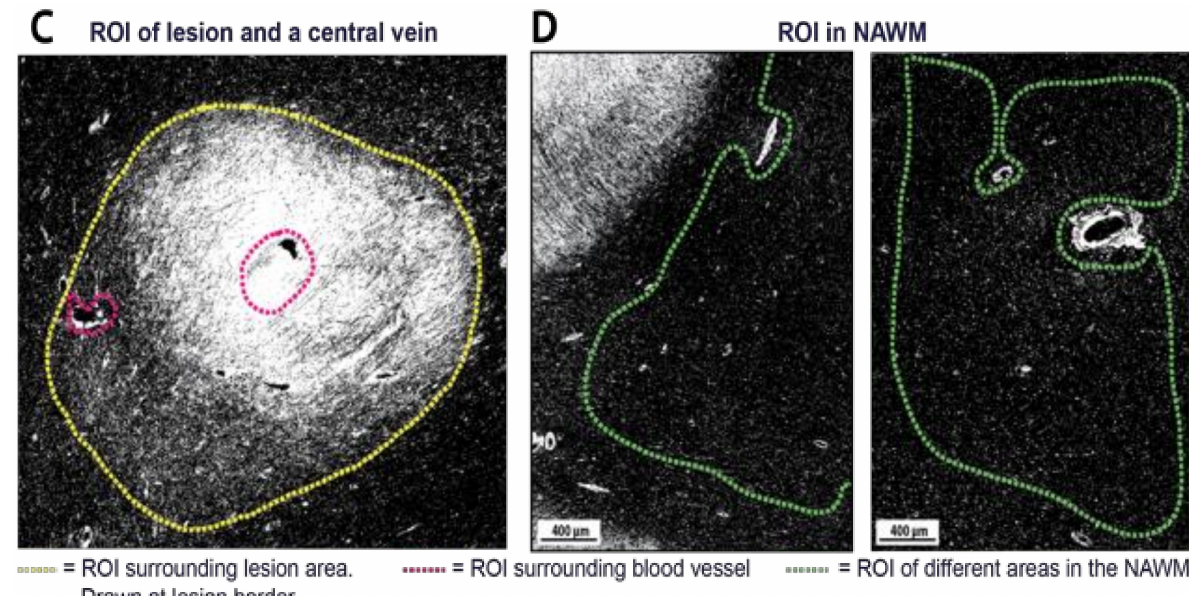
Figure 7. Myelin percentage computation with ImageJ (version 2.0.0/1.52p, https://imagej.net/Fiji/, accessed on 13 Febru- ary 2020). ( A ) The percentage of myelin was quantified from images of Luxol Fast Blue (LFB) stained sections; ( B ) The images were processed into an 8-bit binarized mask of myelin, with the black pixels representing the myelin. A threshold was set at a level that most closely matched the true image (in LFB), in order to retain as many true myelin pixels as possible; ( C ) After ImageJ processing, the ratio of black pixels was divided by the total amount of pixels in the defined region of interest (ROI). The total pixel amount and black pixels of a blood vessel (present within the ROI) were subtracted from the total pixel amount and black pixel amount of the ROI to obtain only percentages of myelin; ( D ) In every brain section, three different ROIs were drawn in the NAWM. The images were taken at the same magnification as the lesion’s image magnification (to maintain the same pixel scale in every image) using Phenochart (version 1.0.12, Perkin Elmer AKOYA Biosciences). The ROI in the NAWM was drawn as pictured above, excluding (large) blood vessels. The percentage of black pixels was computed in the ROI for all 3 areas and averaged to a percentage of myelin. The number of black pixels then indicated the percentage of myelin in lesions, with 100% myelin being defined by the number of black pixels in NAWM (as NAWM represents normal myelin